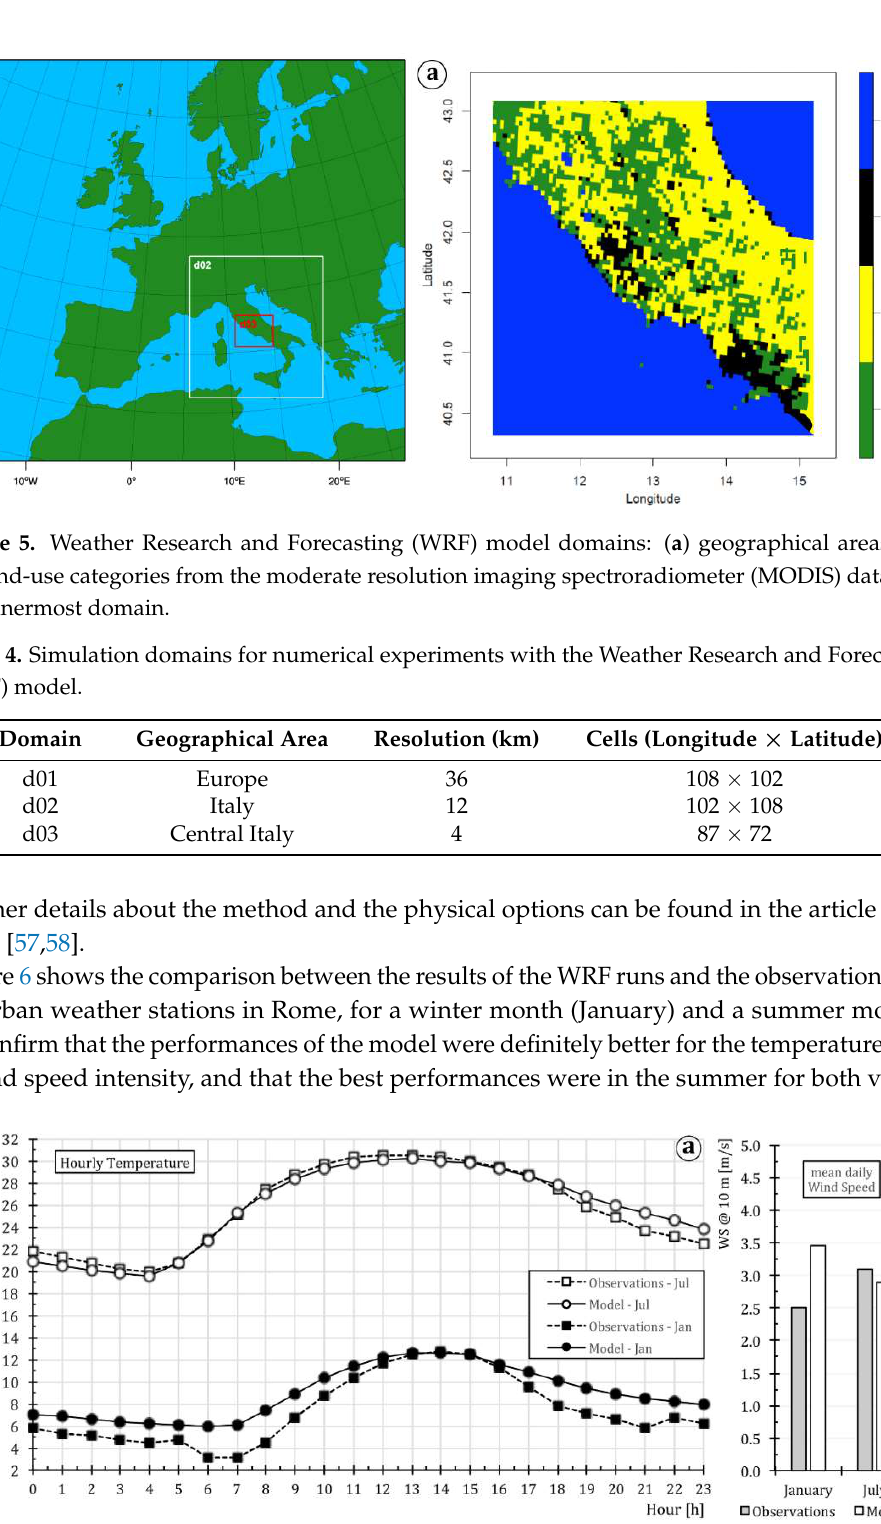
Figure 6. WRF evaluation. Daily cycles of temperature ( ◦ C) and of averaged wind speed (m/s) in the urban area of Rome for January and July 2012: ( a ) 2-m temperature; and ( b ) 10-m wind speed. The standard deviation calculated between modeled and observed values of TBA was equal to 0.44 ◦ C for the month of July and 0.89 ◦ C for the month of January. These results ensured the accuracy of the WRF model, and thus, determined an acceptable approximation for the subsequent energy calculations based on the obtained meteorological